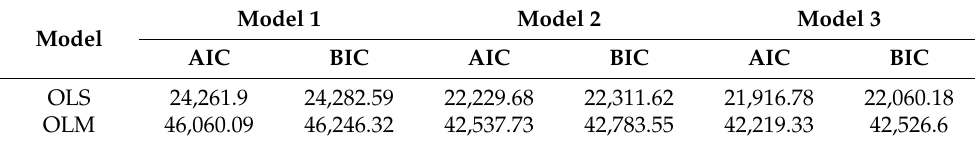
Table A2. Akaike’s and Schwarz’s Bayesian information criteria.